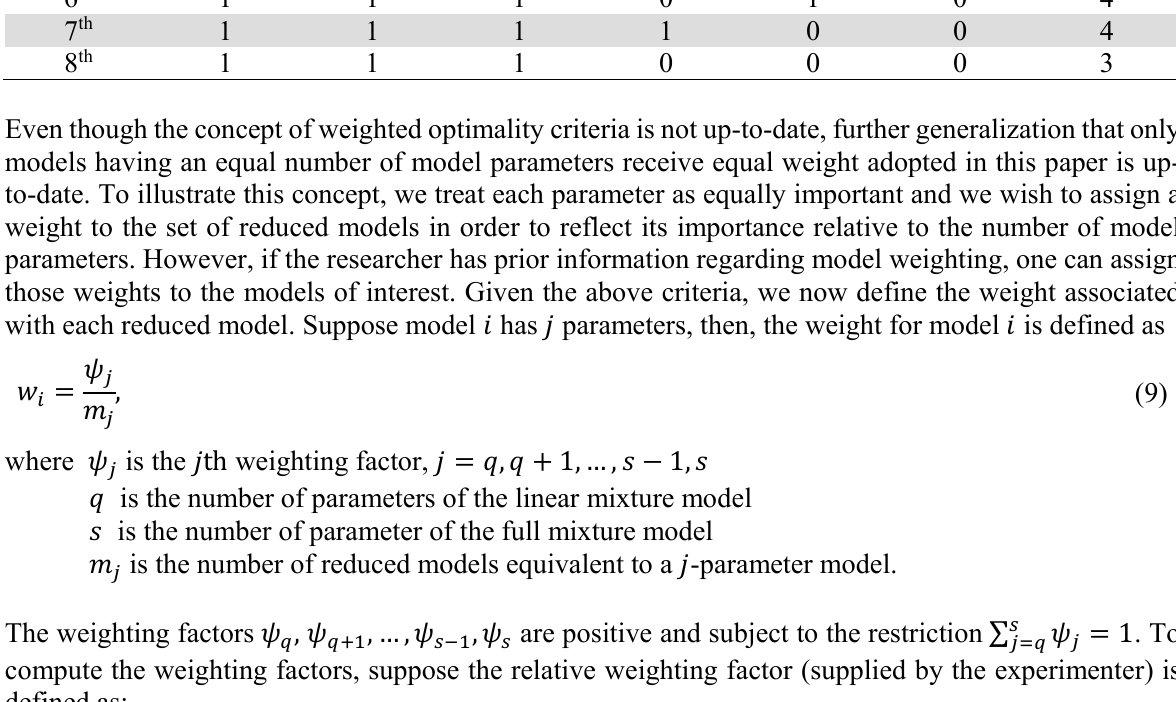
Table 1 The set of reduced models for the full Scheffé quadratic mixture model with three components Model